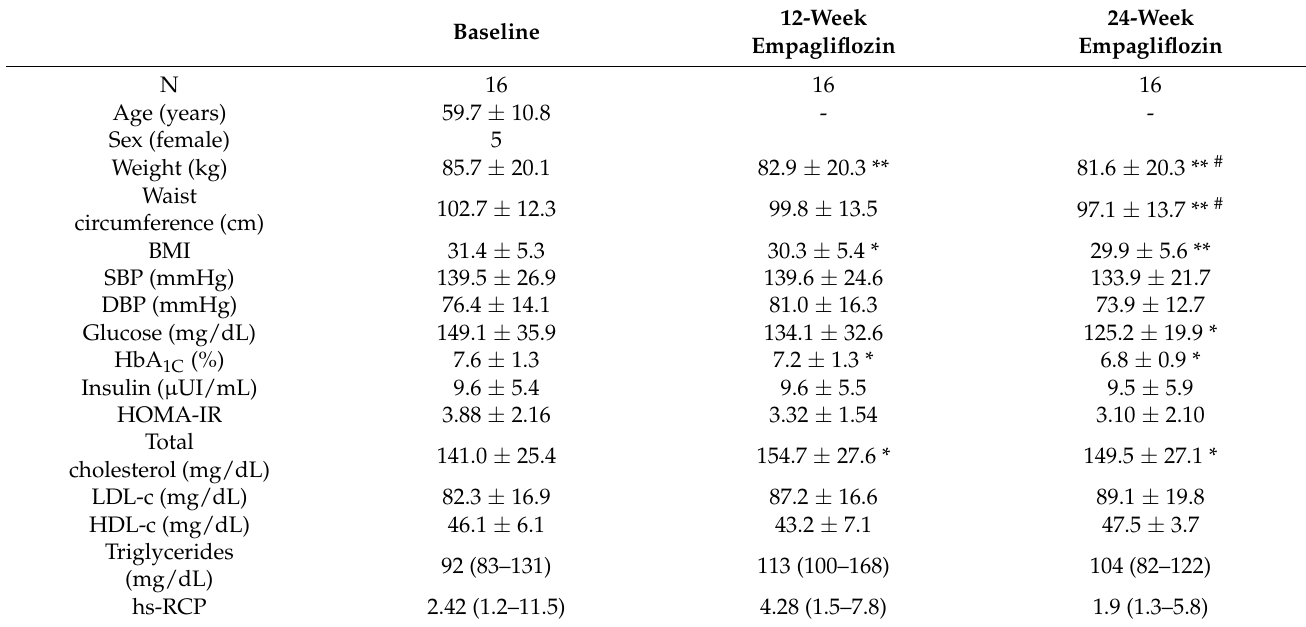
Table 3. Anthropometric characteristics of the study population at baseline, and at 12- and 24-week